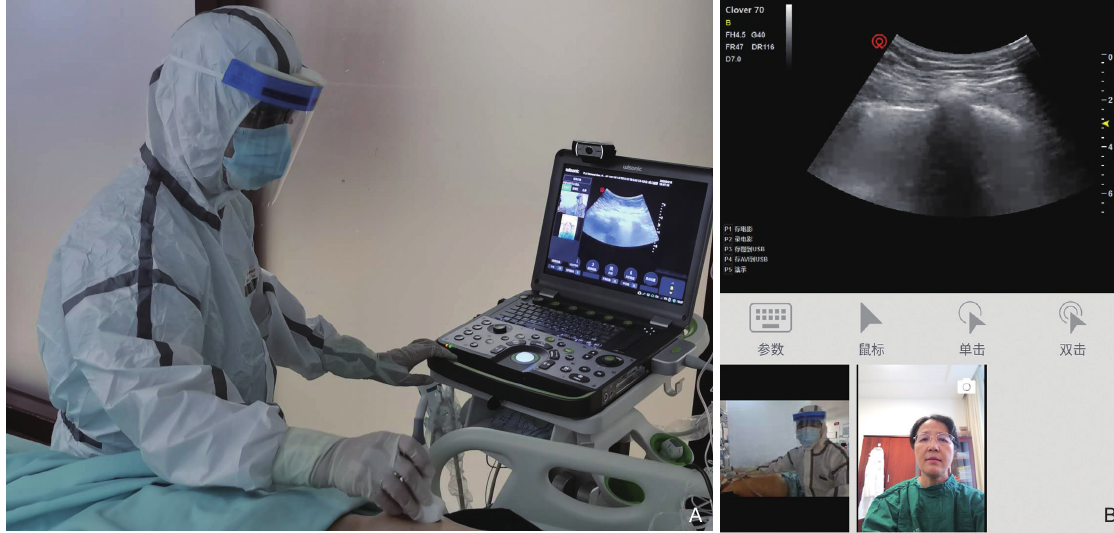
Figure 1 Remote end and consultation end of remote ultrasonography. (A) In the isolation ward, a junior intensive-care physician was using ultrasound to examine unconscious patients at bedside; (B) Ultrasound experts stayed at the consultation end, providing remote ultrasound guidance to doctors in the isolation ward.